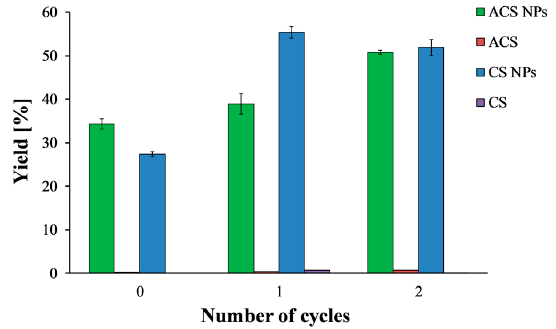
Figure 3. ACS (green) and CS (blue) nanoparticle yield as a function of the number of freeze/thaw cycles. ACS (purple) and CS (red) polymer solutions were examined as a control.